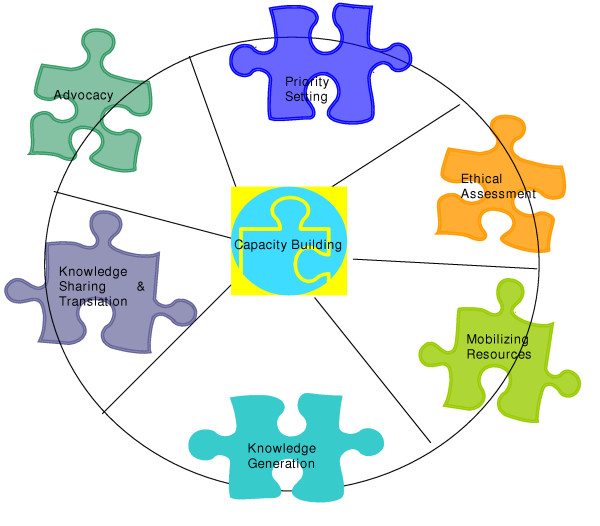
Research Process